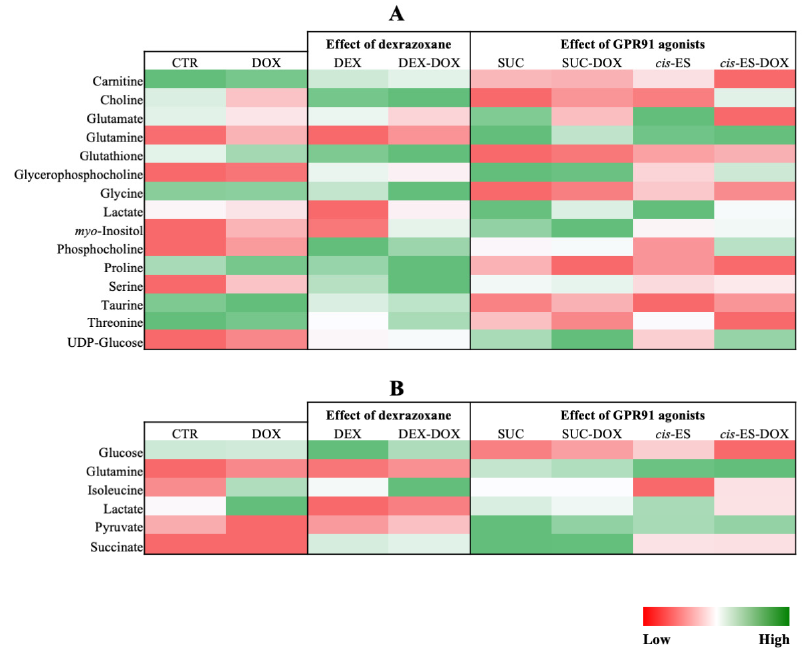
Figure 5. Heatmaps constructed from the relative means of the discriminant metabolite normalized integrals. ( A ) Intracellular compartment. ( B ) Extracellular